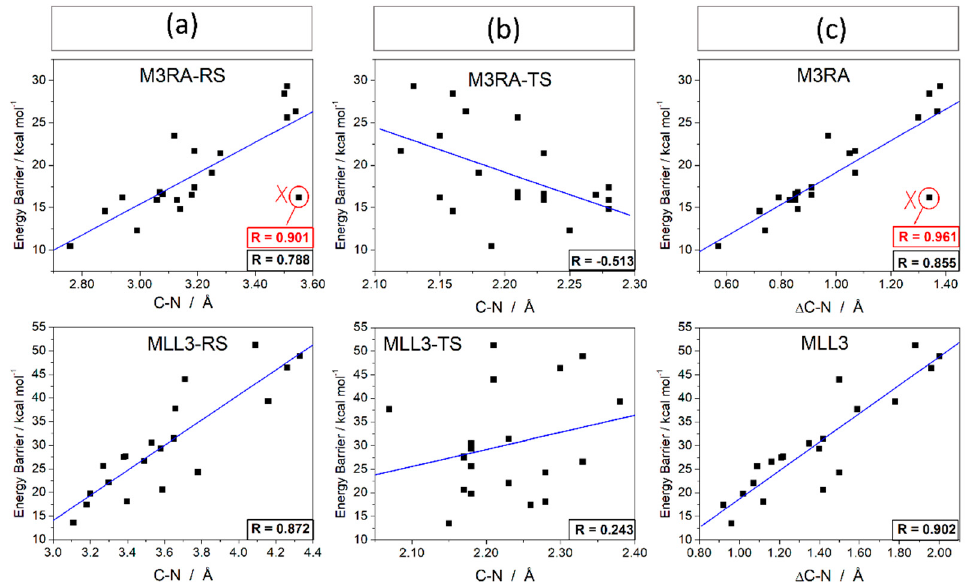
Figure 4. Plot of the distance between the atoms involved in the reaction coordinate for the methyl transfer process, namely the methyl carbon from SAM and the nitrogen from Lys4, versus the energy barrier ( ∆ E ≠ ). The correlation factor for the complete data set is in black, and in red is the factor after removing the data in the red circle. ( a ) Reactant state ( b ) Transition state ( c ) Difference between the distances from the reactant and the transition state